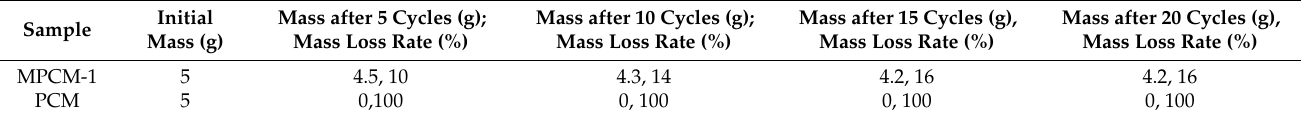
Figure 13. Digital photographs of ( a ) initial samples and ( b ) samples after thermal cycles. Table 7. Mass loss of MPCM-1.